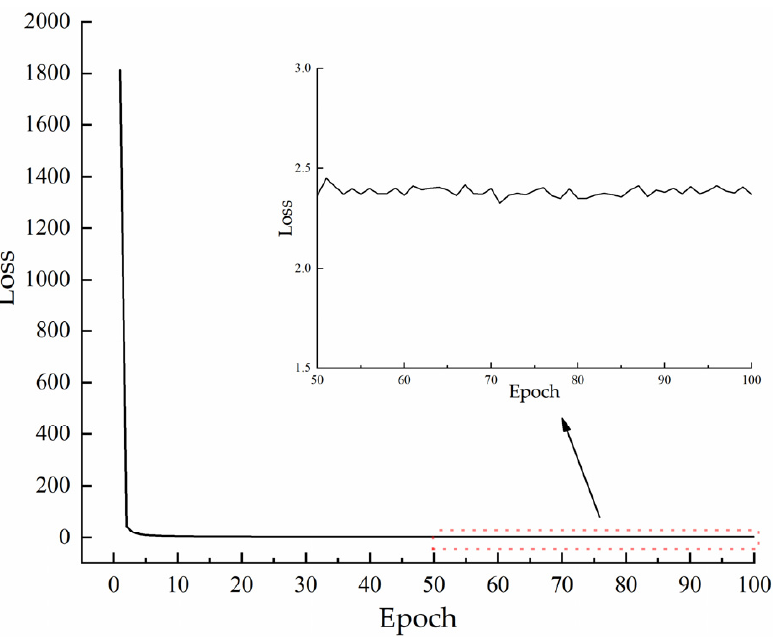
Figure 9. Variation of model loss values with the number of training iterations.